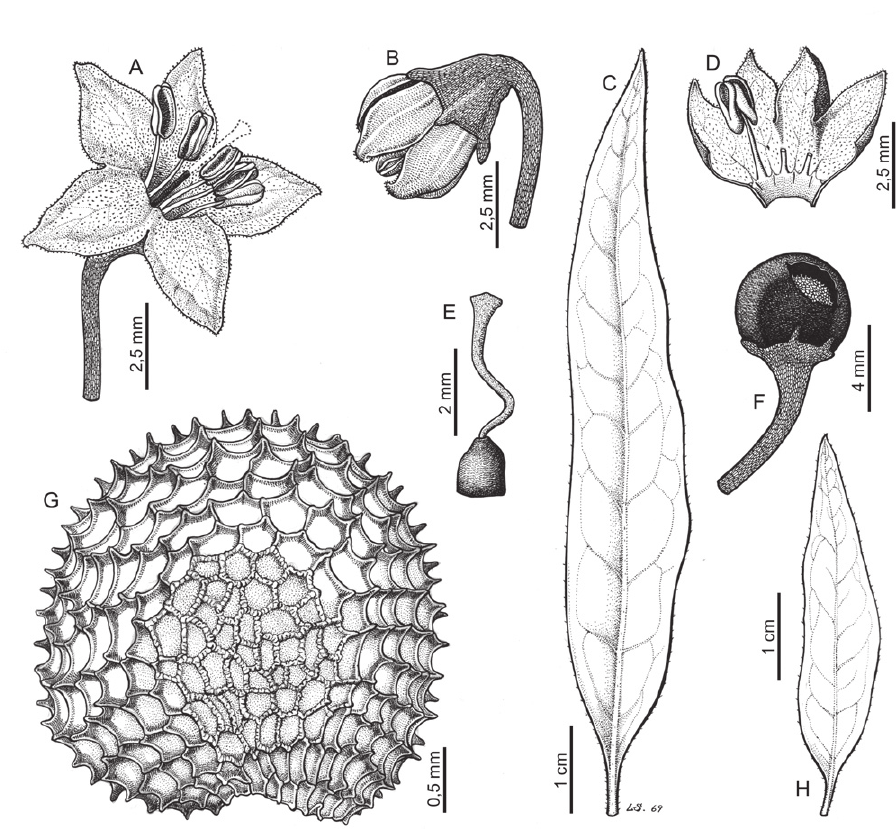
Figure 1. Capsicum mirabile . A fl ower B fl ower bud C, H leaf D open corolla E gynoecium F fruit G seed. Line drawing by L. Sánchez; voucher Martius s. n.,